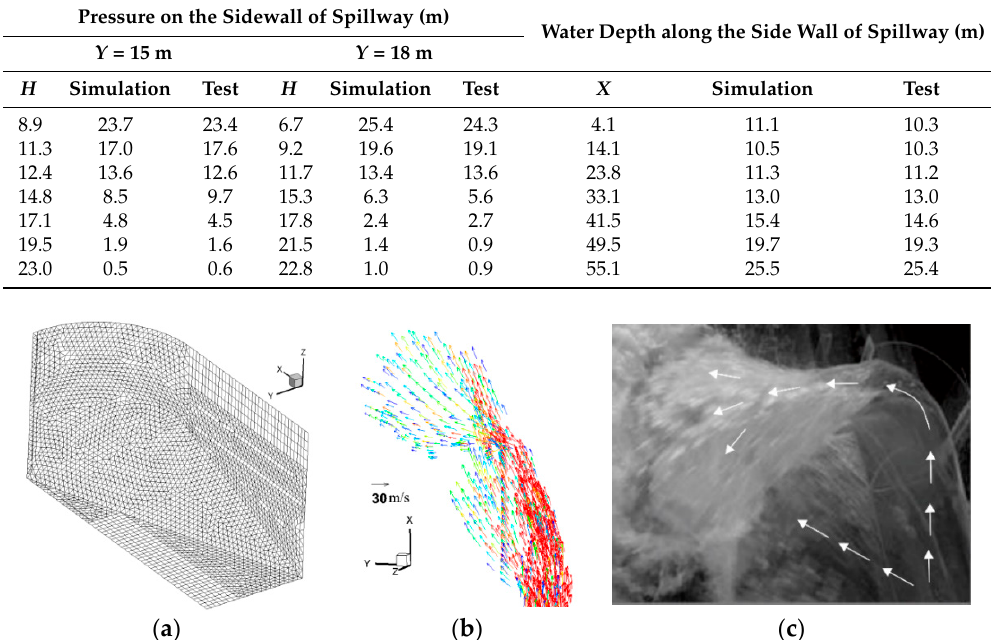
Figure 4. Comparison of numerical simulation with experimental flow: ( a ) a sample of computational mesh in the spillway area; ( b ) velocity vector profile; ( c ) experimental image.